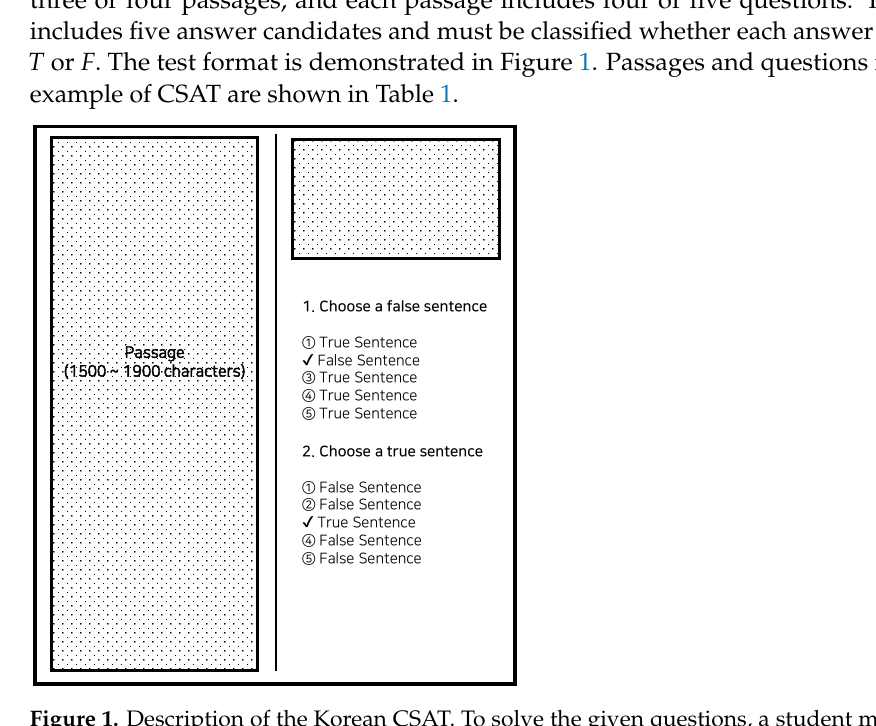
Figure 1. Description of the Korean CSAT. To solve the given questions, a student must be able to select which question is T / F out of the multiple-choice questions. Table 1. Example of passage and question in the Korean